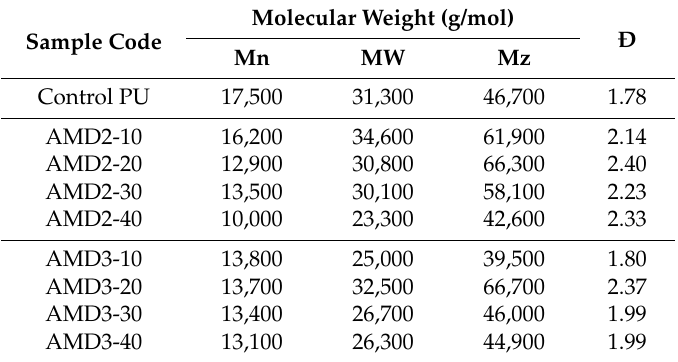
Figure 2. FT-IR spectra of prepared AMD based PUEs: ( A ) full spectra; and ( B ) magnified spectra. Table 2. Molecular weights of synthesized PUEs.